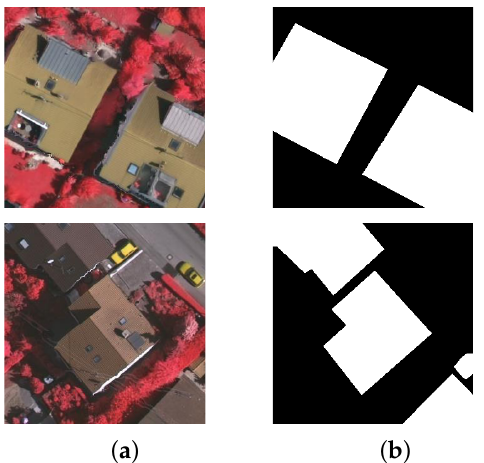
Figure 2. Two example images and the ground-truth segmentation results for our dataset: ( a ) Test images; ( b ) ground-truth building regions by human